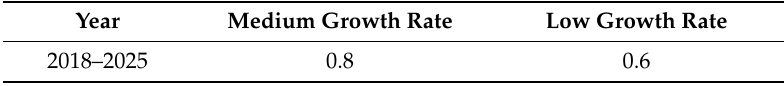
Table 5. Values set for population growth rates of China from 2018 to 2025 (%).